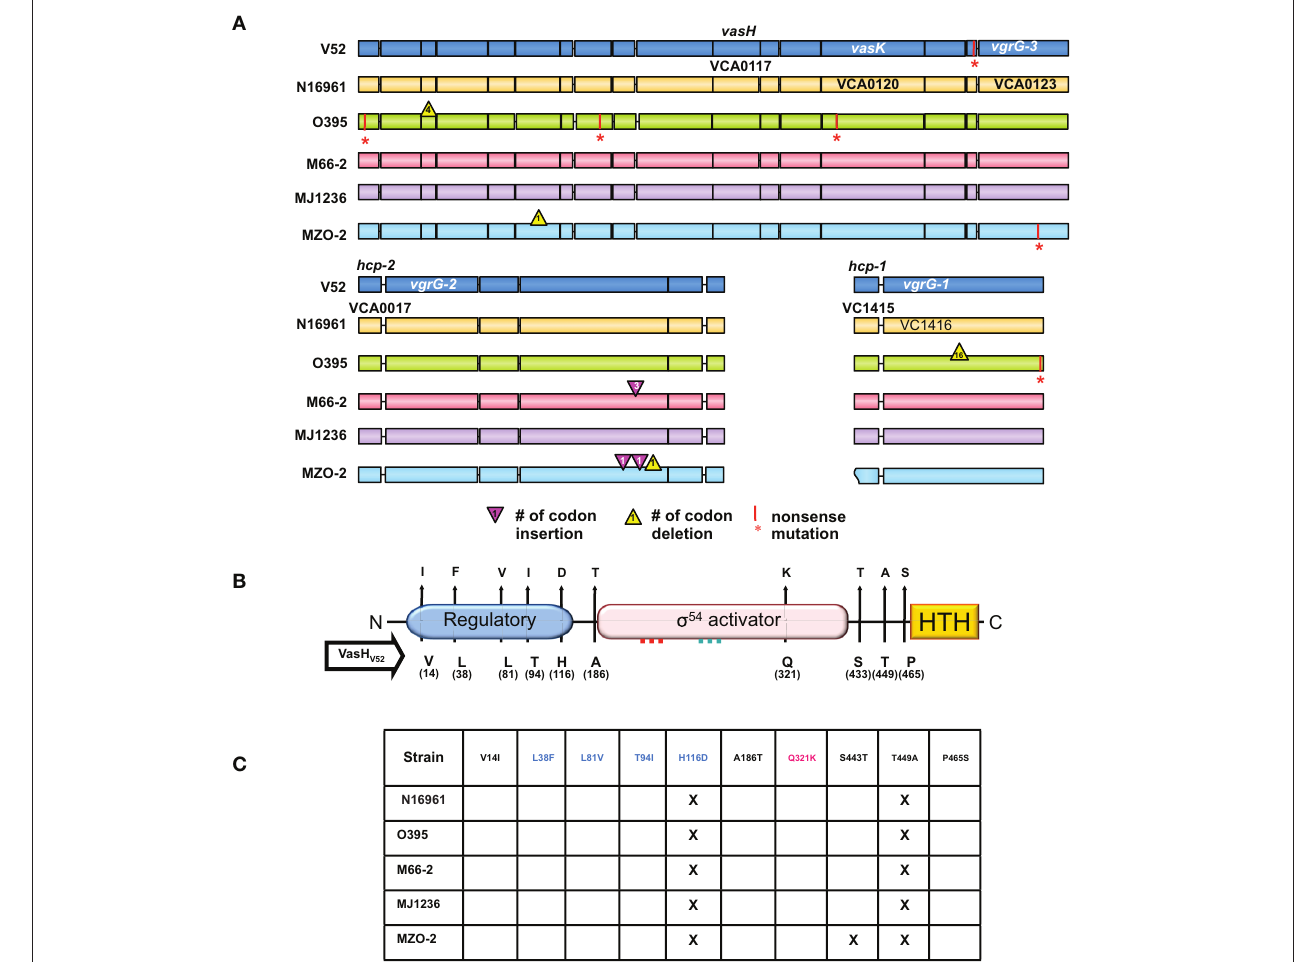
insertion/deletion size (number of codons). Rough ends of a gene indicate that the complete sequence was not available. (B) Polymorphic domains of VasH. Graphical depiction of VasH from the O37 serogroup strain V52 (V52_VasH) with its putative N-terminal regulatory domain (blue), core sigma-54 activator domain (pink), and C-terminal helix-turn-helix (HTH) domain (yellow) (drawn to scale). Conserved amino acid substitutions are indicated by arrows. The residue and its position in VasH of V52 is indicated below the line and the substitutions found in other strains are indicated above the arrowhead. (C) Allelelic VasH variants. Listed are VasH variants of different V. cholerae strains compared to VasH in V52. Amino acid substitutions are listed for each variant. Font color indicates in which of the three domains the substitution is